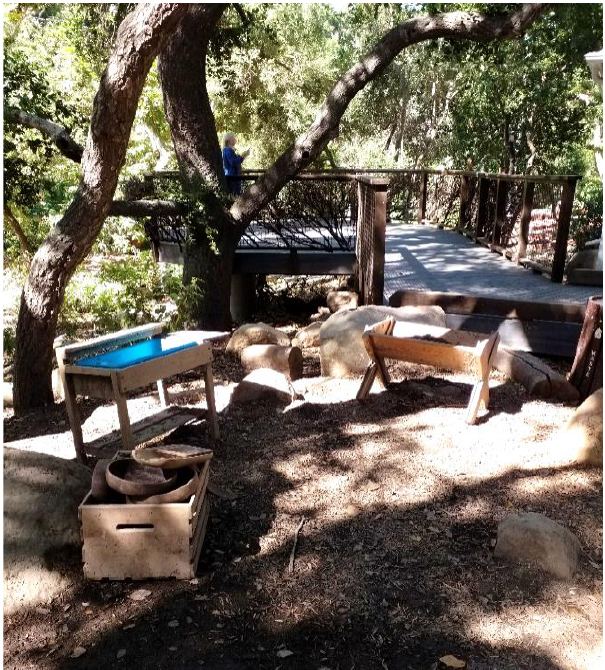
Figure 2. Stump circle and stage areas.